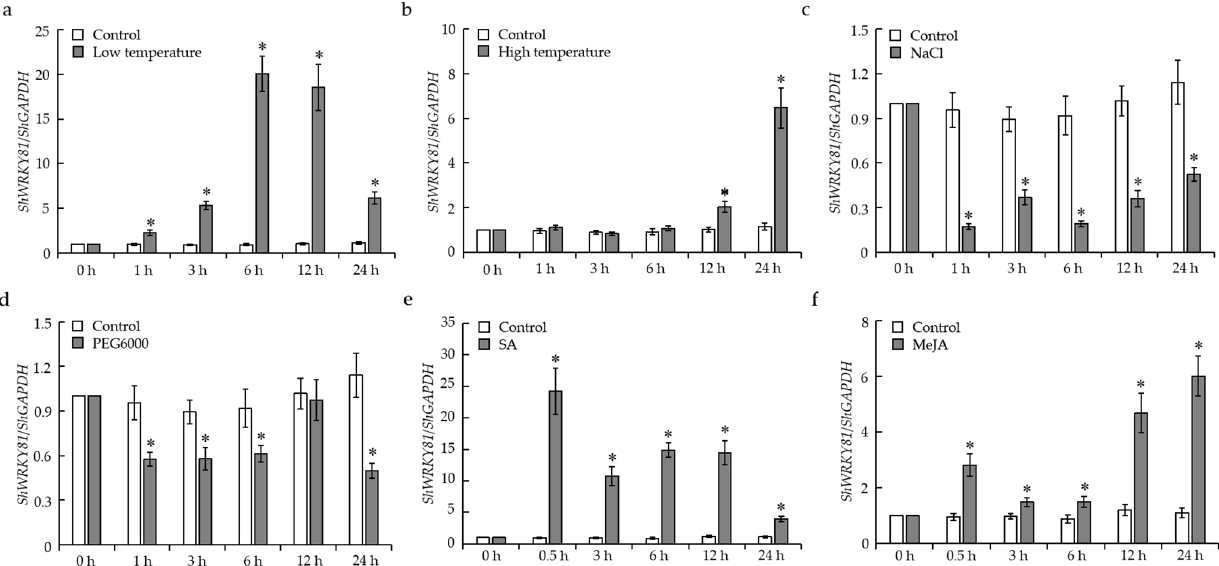
Figure 4. Expression profiles of the ShWRKY81 transcripts under different abiotic stresses and phytohormone treatments in LA1777. Expression levels of ShWRKY81 were determined at the indicated time points by quantitative real-time PCR (qRT-PCR) in 4-week-old LA1777 seedlings treated with low temperature ( a ), high temperature ( b ), 200 mM NaCl ( c ), 20% ( w / v ) PEG6000 ( d ), 200 µM SA ( e ), and 100 µM MeJA ( f ). ShGAPDH was used as an internal reference. Values are shown as the means ± standard error of three biological replicates, and statistically significant differences are represented by asterisks (Student’s t -test, *, p < 0.05).